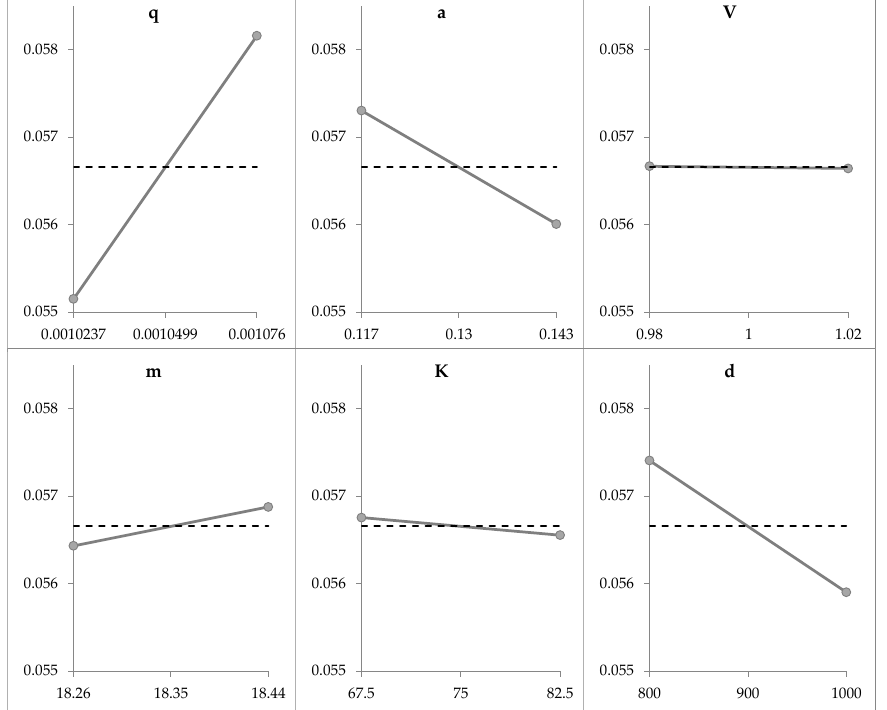
Figure 11. PLS correlations loadings plot.